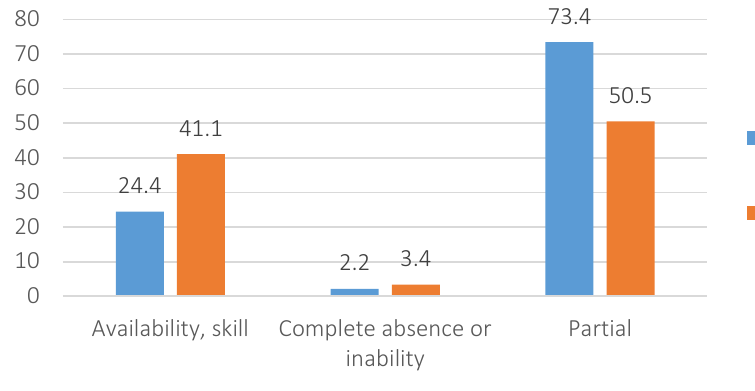
Figure 1. Ability to manage time